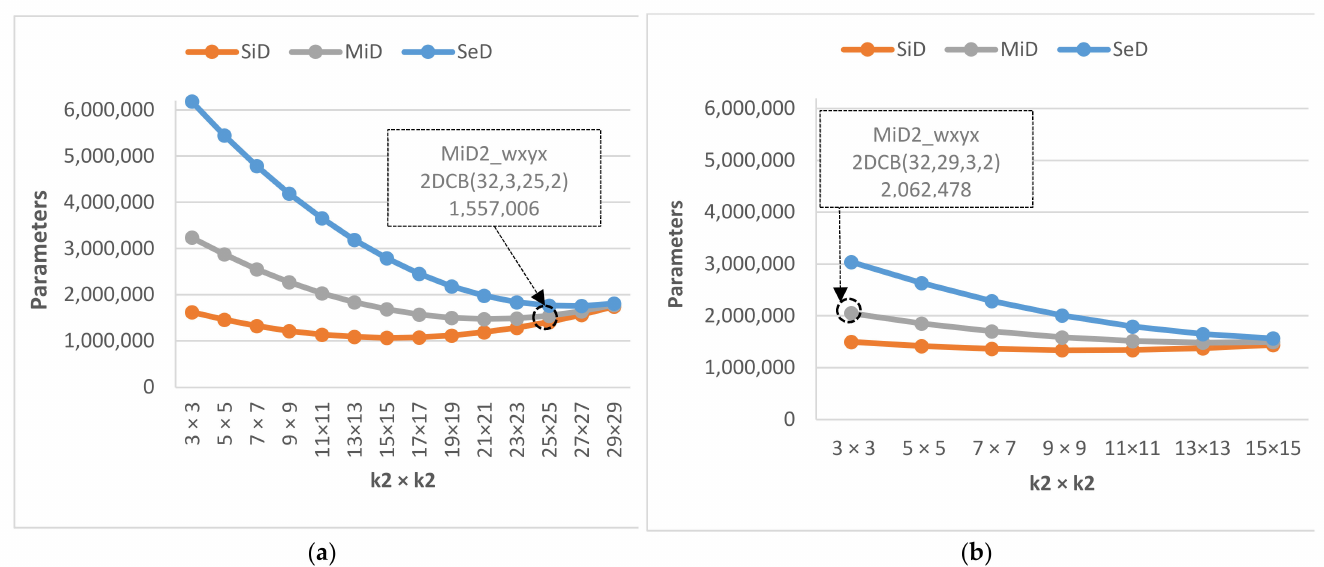
Figure 14. Number of parameters for architectures SiD, MiD y SeD: ( a ) size kernel k1 ≤ k2; ( b ) size kernel k1 >